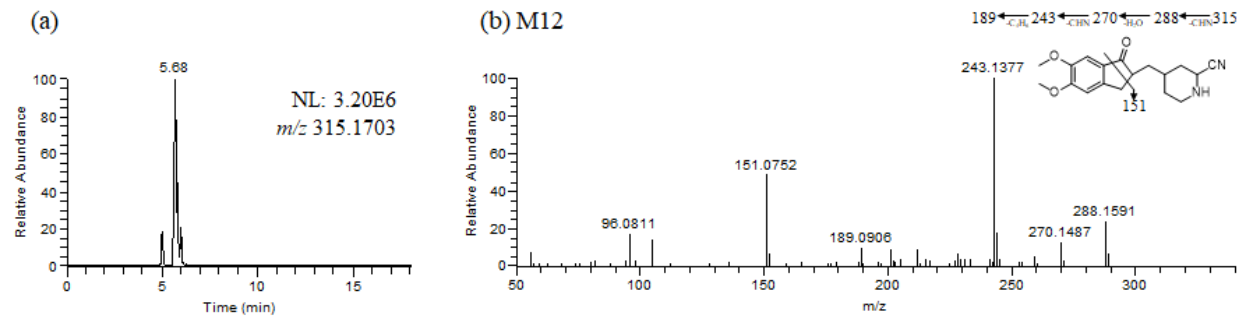
Figure 5. Representative extracted ion chromatograms ( a ), product ion scan mass spectrum and proposed fragmentation scheme ( b ) of reactive metabolites produced from the incubation of donepezil with rat liver microsomes in the presence of nicotineamide adenine dinucleotide phosphate reduced form and potassium cyanide (1 h, 37 °C).